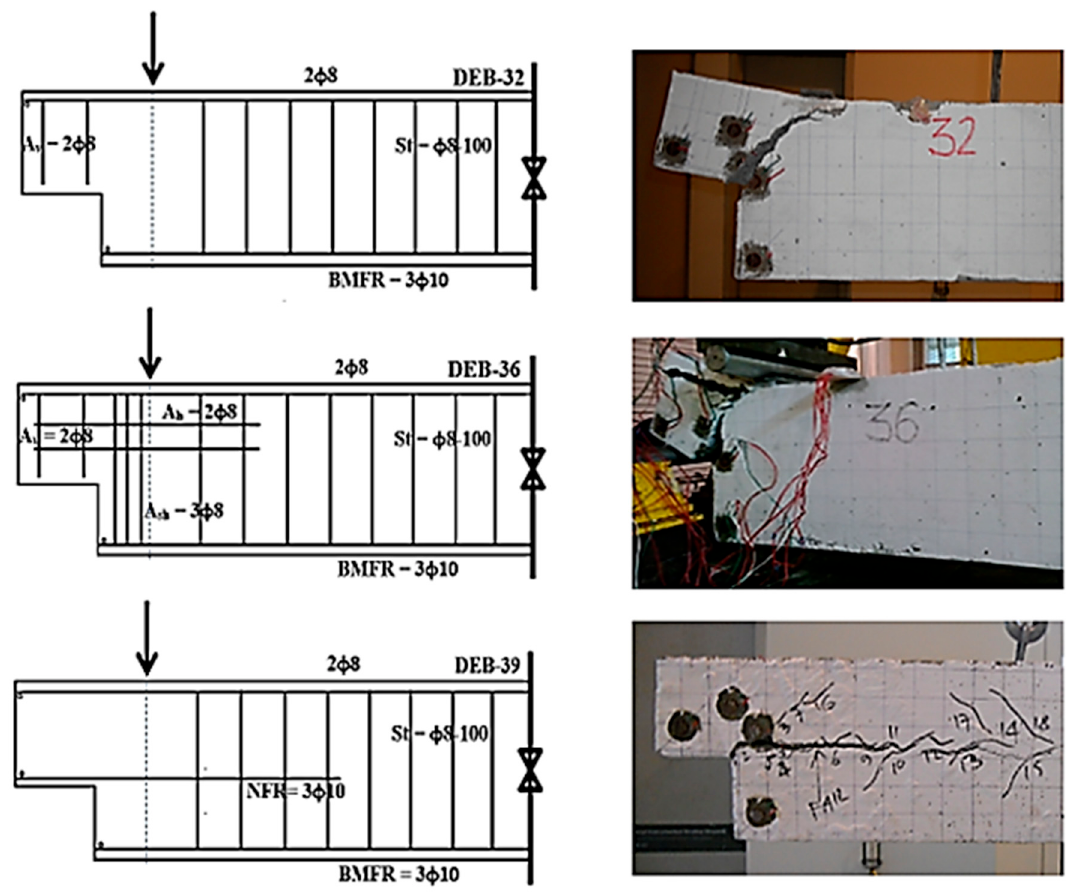
Figure 9. Reinforcement detail and modes of failure for DEB-32, DEB-36, and DEB-39.